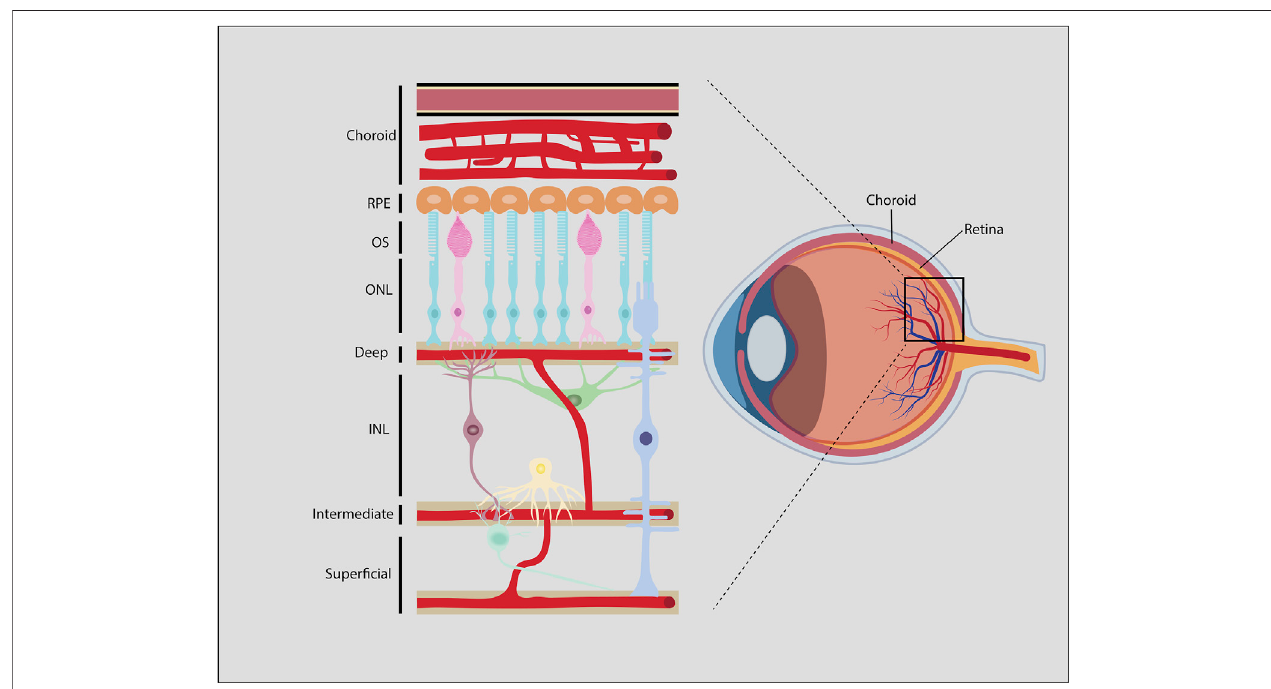
FIGURE 7 | Blood-retinal-barrier (BRB). Generalized schematic of the mammalian BRB, showing retinal vessels, some species like zebra fi sh, chicken and rabbit may have differentvasculararchitecture.Endothelialcellsand associatedpericytes thatlinethedeep, intermediate, andsuper fi cialvascular pleximake uptheinner BRB (iBRB). The RPE is part of the outer BRB (oBRB) that prevents blood-borne factors from entering the retina from the choroidal vessels.